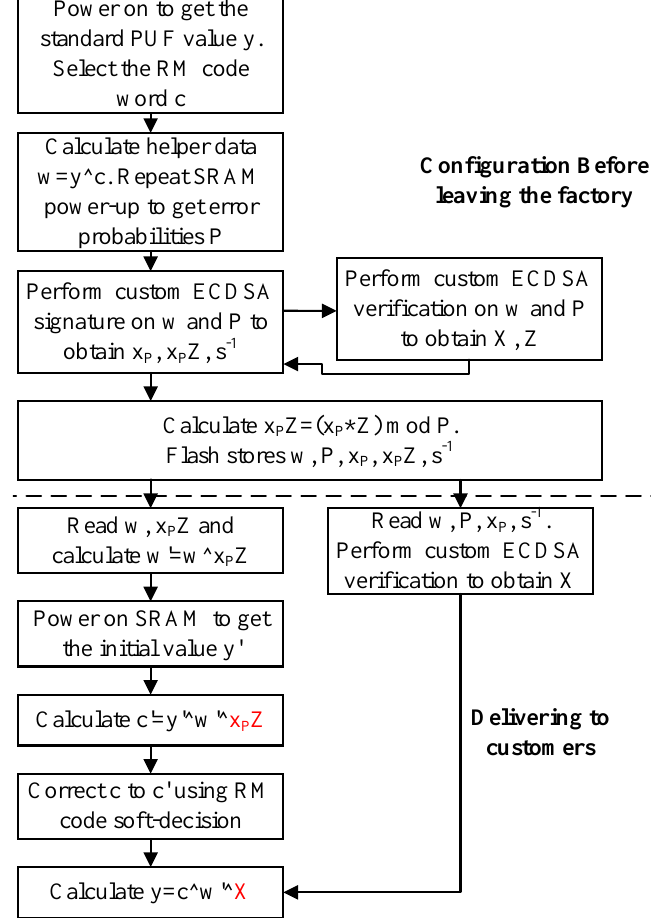
Figure 11. Optimized fast ECDSA-PUF